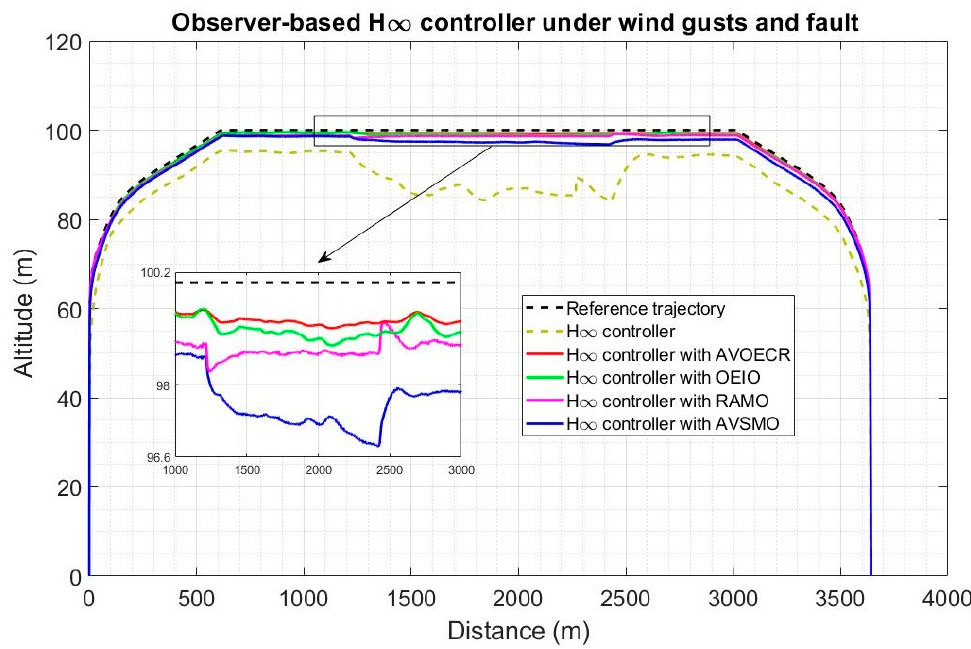
Figure 15. Quadplane trajectory tracking comparison under a 5 m/s wind intensity with an elevator fault between 80 s and 120 s, with a H ∞ benchmark controller.